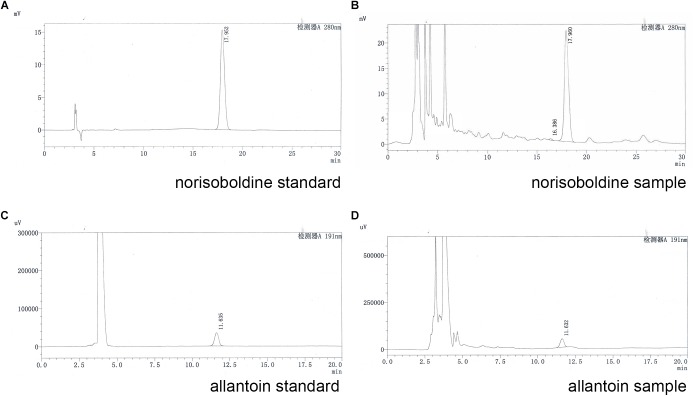
HPLC chromatogram of standards and samples; (A) norisoboldine standard; (B) norisoboldine sample; (C) allantoin standard; (D) allantoin sample.